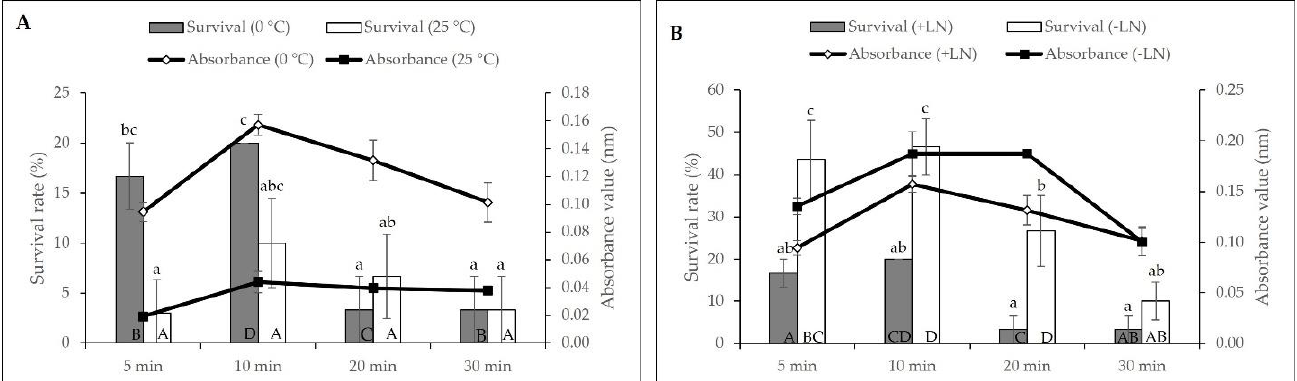
Figure 3. Effect of PVS2 dehydration duration on the viability of ( A ) cryopreserved (+LN) axillary buds at 0 °C and 25 °C and ( B ) cryopreserved (+LN) and non-cryopreserved (-LN) axillary buds at 0 °C. Error bars represent standard errors. Means with different letters (upper case: Absorbance; lower case: Survival) are significantly different based on Duncan Multiple Range Test (DMRT) at p ≤ 0.05.